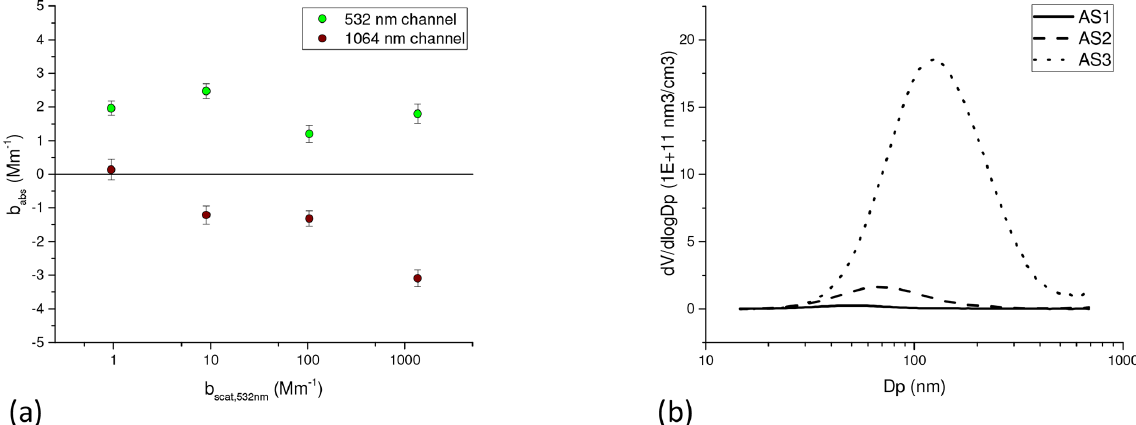
Figure 13. Scattering artefact for different samples of ammonium sulfate (a) . Volume size distributions of ammonium sulfate samples (b) .